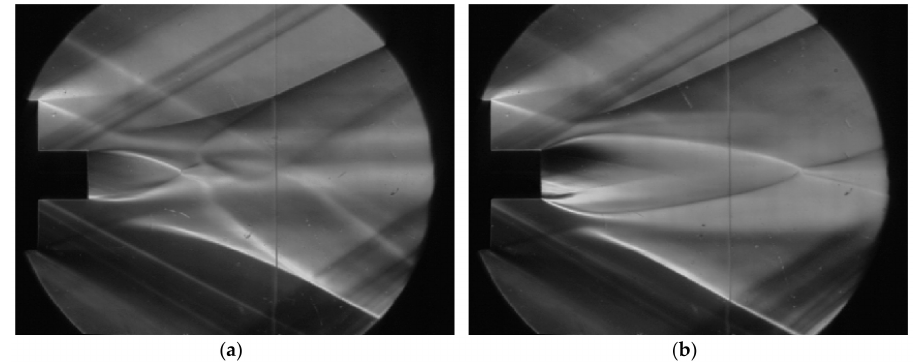
Figure 9. Schlieren photo of the field of external supersonic flow with Mach number M = 2 past an axisymmetric model in the presence of a supersonic jet exhausted from a nozzle located at the base region; the design nozzle Mach number is M a = 3.95 at nozzle pressure ratios of 55.3 ( a ) and 366 ( b